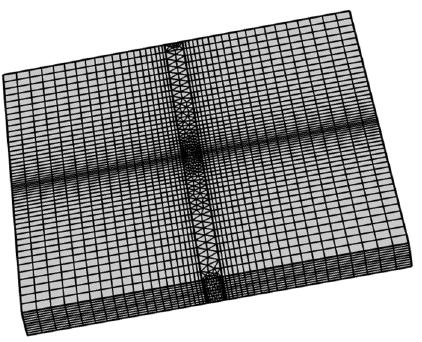
Figure 1. Finite element welding model.